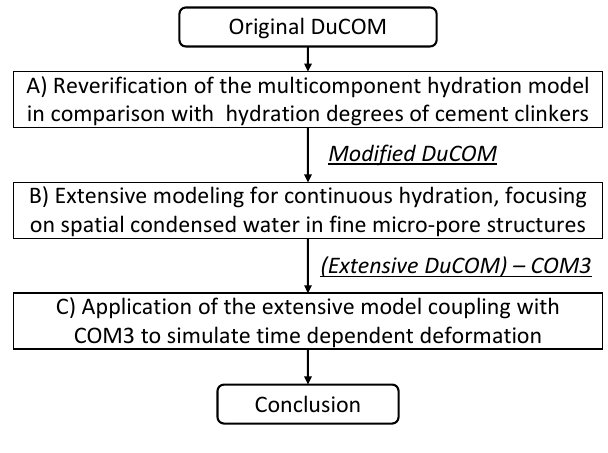
Figure 5. Configuration of this study.